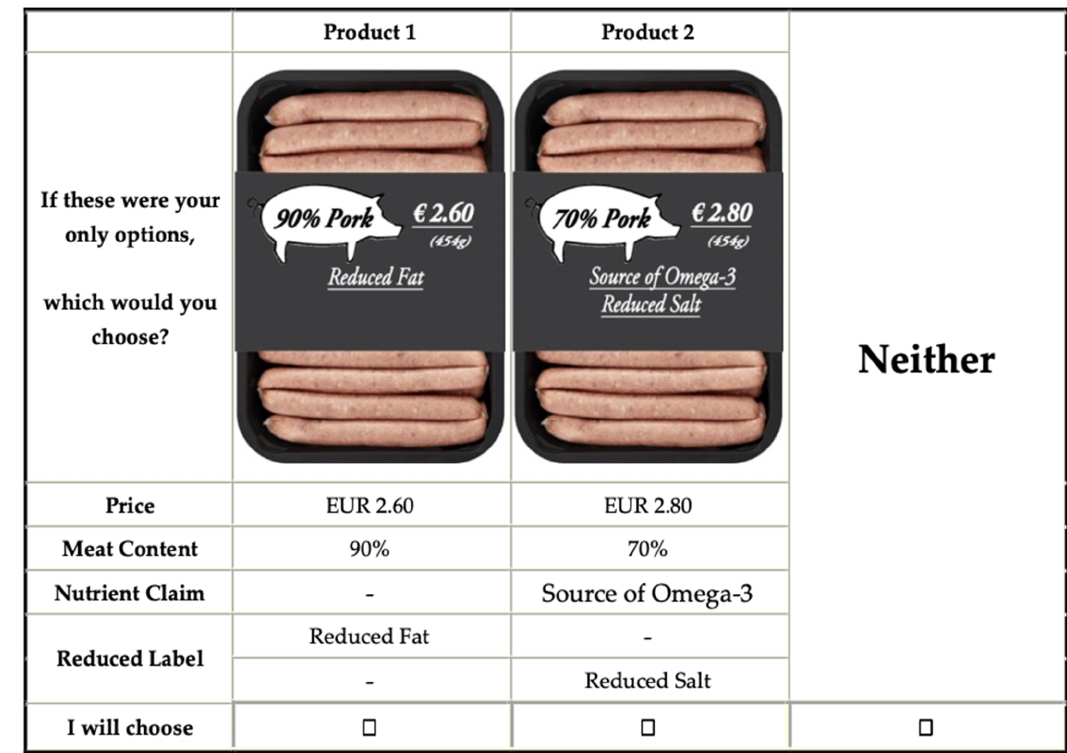
Figure A10. Choice set 10 in the questionnaire.